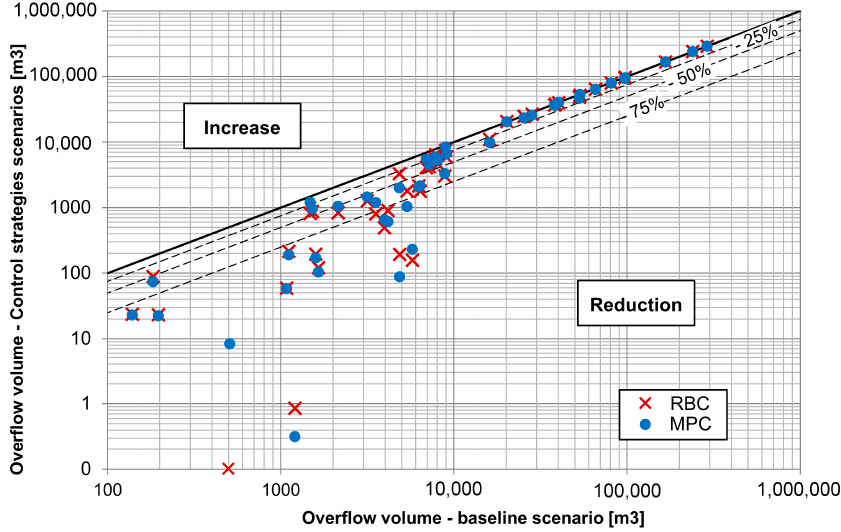
Figure 3. Event overflow volumes discharged at the catchment scale for the rule-based real time control (RBC) and model predictive control (MPC) scenarios compared to the corresponding baseline scenario results. The dotted lines represent percentile reductions.